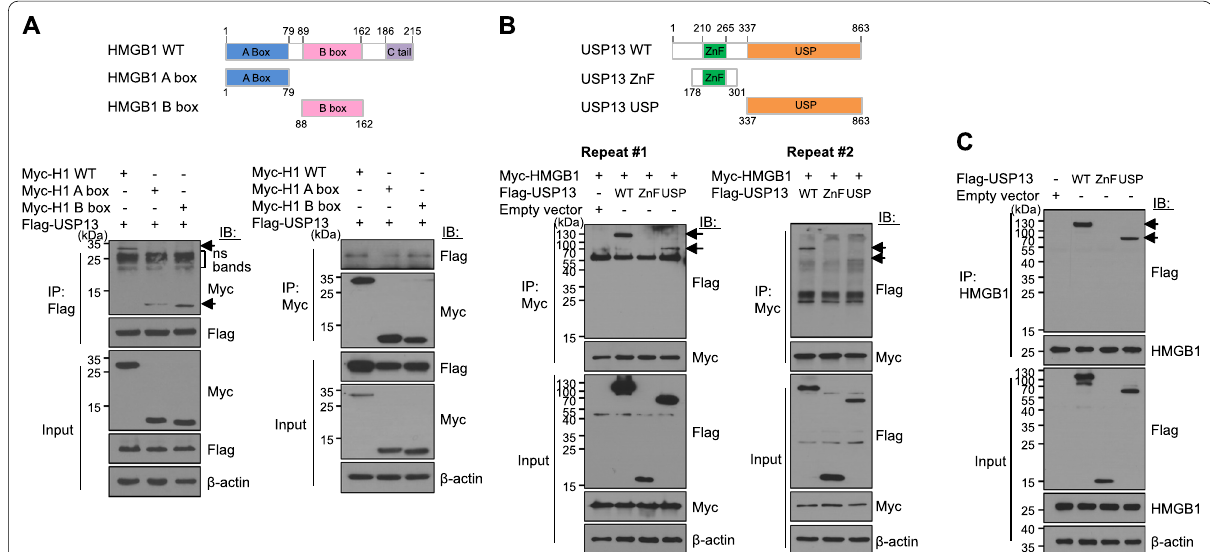
Fig. 2 Binding domain study between HMGB1 and USP13. A HMGB1 wild type (WT), A , B boxes (upper panel). HEK293T cells were co‑transfected with either Myc‑HMGB1 A or B box and Flag‑USP13 plasmid (lower panel). Immunoprecipitations (IPs) using anti‑Flag and anti‑Myc antibodies were done. ns: non‑specific. WCLs were immunoprecipitated (IP) and immunoblotted (IB) with indicated antibodies. B USP13 WT, USP13 ZnF, and USP domains (upper panel). HEK293T cells were co‑transfected with both Myc‑HMGB1 and Flag‑USP13 WT or USP13 ZnF or USP13 USP domain plasmids (lower panel). WCLs were immunoprecipitated (IP) and immunoblotted (IB) with indicated antibodies. C HEK293T cells were transfected with Flag‑USP13 WT, ZnF, and USP domain plasmids alone, and immunoprecipitated with anti‑HMGB1 Ab to confirm the binding of the domain of